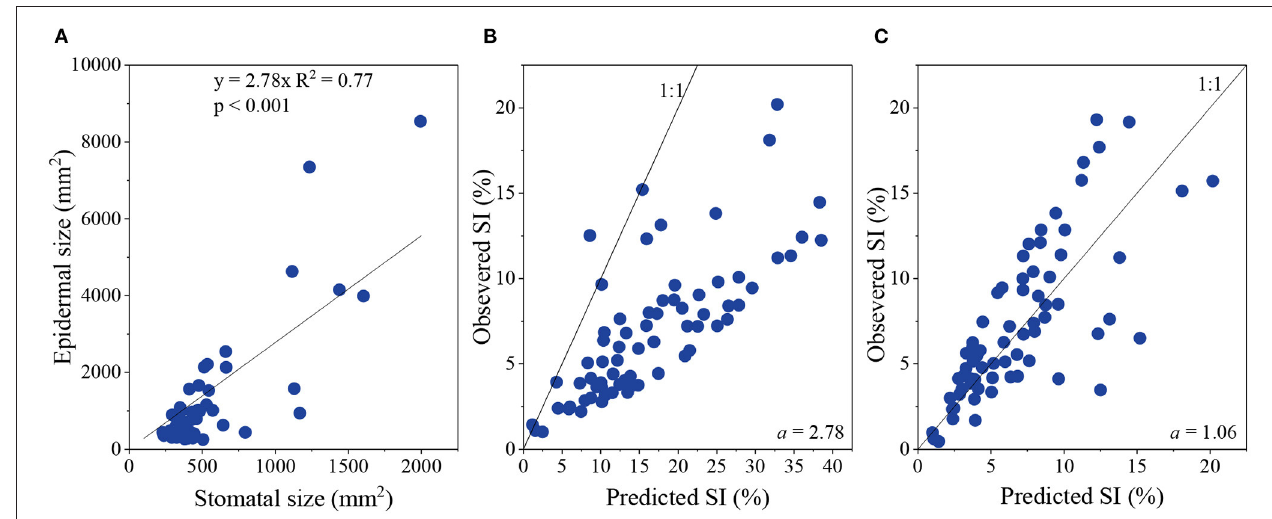
FIGURE 2 | Relationship between epidermal size and stomatal size (A) , and between observed stomatal index (SI) and predicted SI when a was 2.78 (B) and 1.06 (C) , respectively.